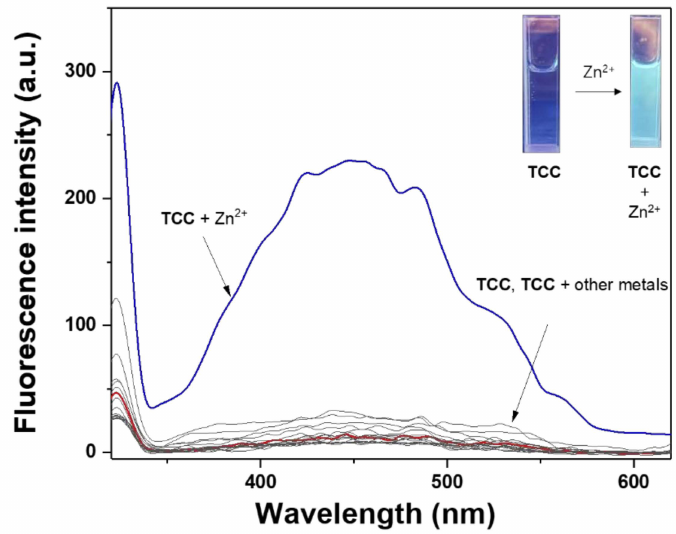
Figure 1. Fluorescence spectral response of TCC (4.0 × 10 − 5 M) toward diverse metal ions (Zn 2+ , K + , Pb 2+ , Na + , Cu 2+ , Hg 2+ , Fe 2+ , Cd 2+ , Mn 2+ , Mg 2+ , Ca 2+ , Ni 2+ , Ga 3+ , Cr 3+ , Fe 3+ , Co 3+ , In 3+ and Al 3+ ; λ ex = 320 nm). Inset: Fluorescent pictures of TCC (4.0 × 10 − 5 M) and TCC (4.0 × 10 − 5 M) with Zn 2+ (1.6